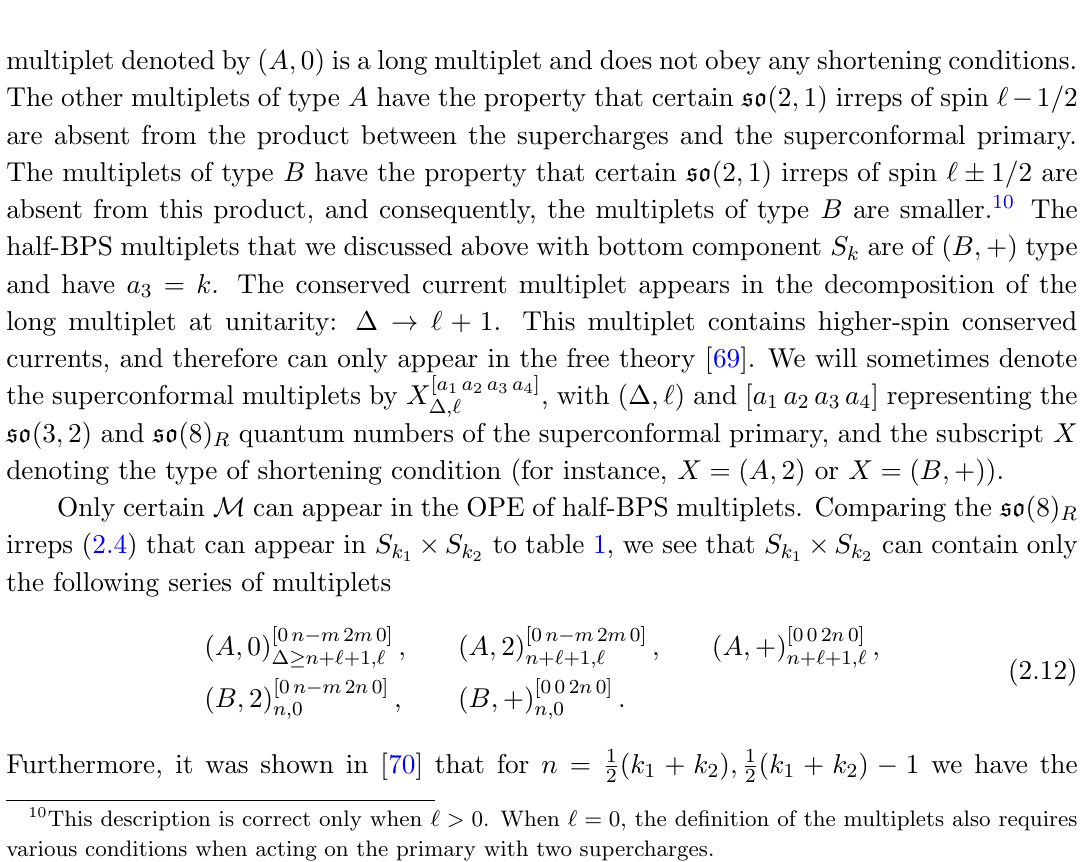
Table 1 . Multiplets of osp (8 j 4) and the quantum numbers of their corresponding superconformal primary operator. The conformal dimension (cid:1) is written in terms of (cid:1) 0 (cid:17) a 1 + a 2 +( a 3 + a 4 ) = 2. The Lorentz spin can take the values ‘ = 0 ; 1 = 2 ; 1 ; 3 = 2 ; : : : . Representations of the so (8) R-symmetry are given in terms of the four so (8) Dynkin labels, which are non-negative